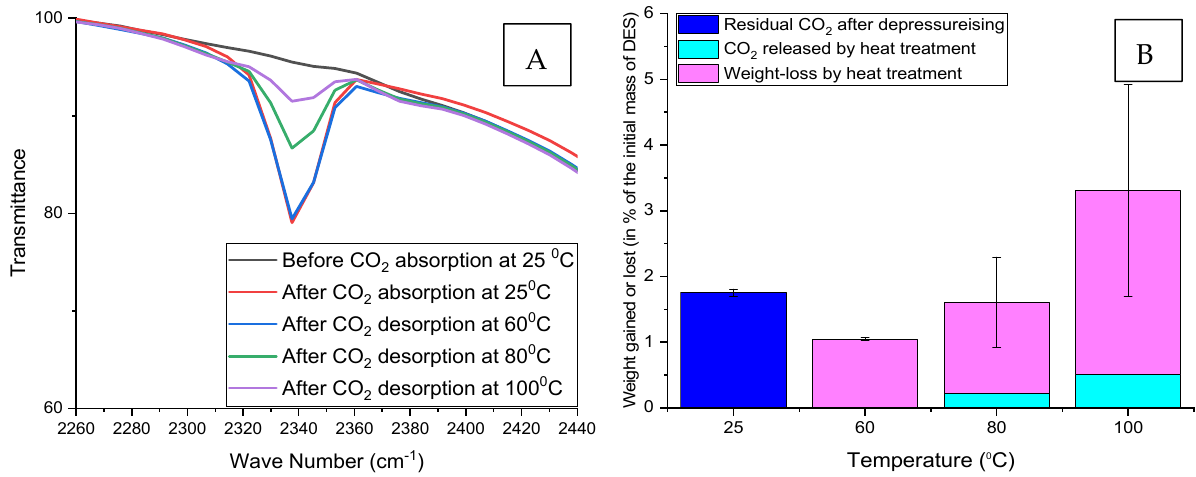
Figure 11. Regeneration of ChCl:LvAc (1:3:0) after CO 2 absorption at 25 °C. ( A ) Reduction in FTIR transmittance peak associated with the double carbonyl group with increasing regeneration temperature; ( B ) residual CO 2 after depressurisation, CO 2 released by heat treatment and weight loss after regeneration at different temperatures.